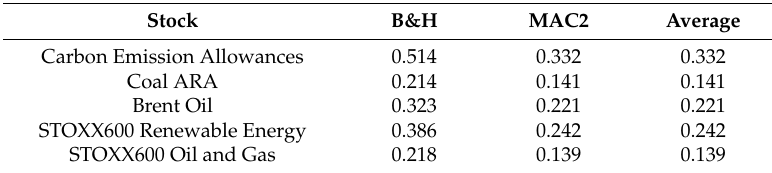
Table A14. Annualized daily (every fifth month) volatility of MAC2 (C = every fifth month, and 2 is the number of observations in the rolling window), average annualized